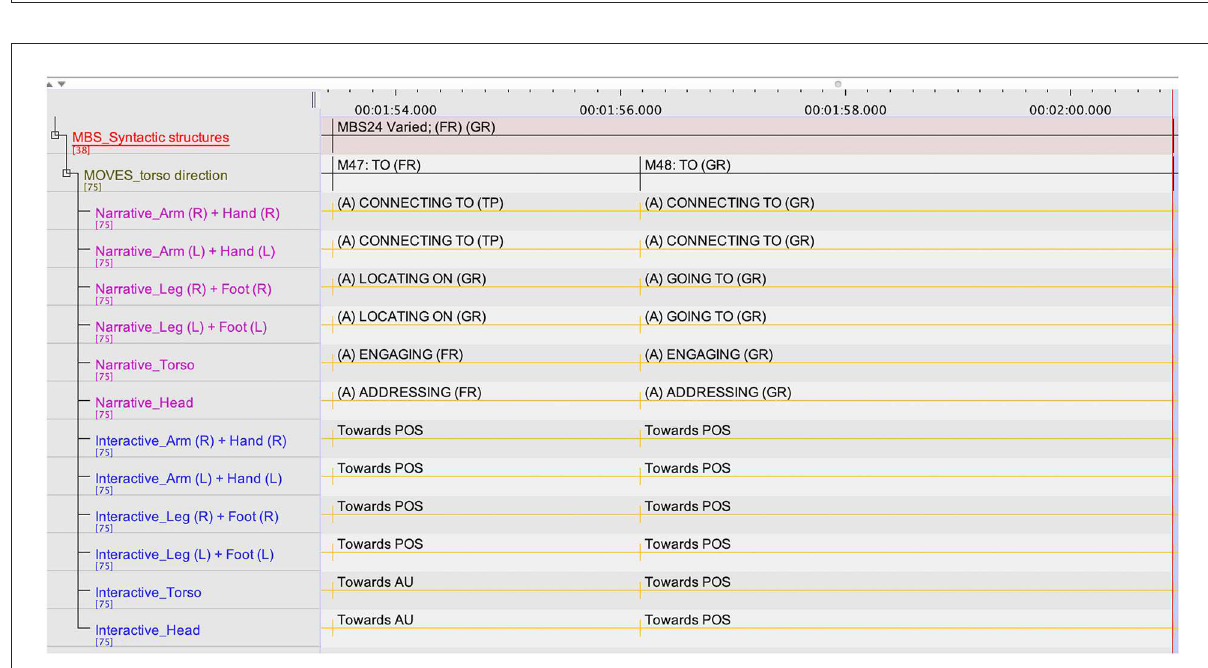
annotation values of moves 47 and 48 code the arrival points of the two moves, respectively. The media frames of the arrival points of moves 47 and 48 are presented in Figures 5, 6. A list of participants and space values is provided at the end of the